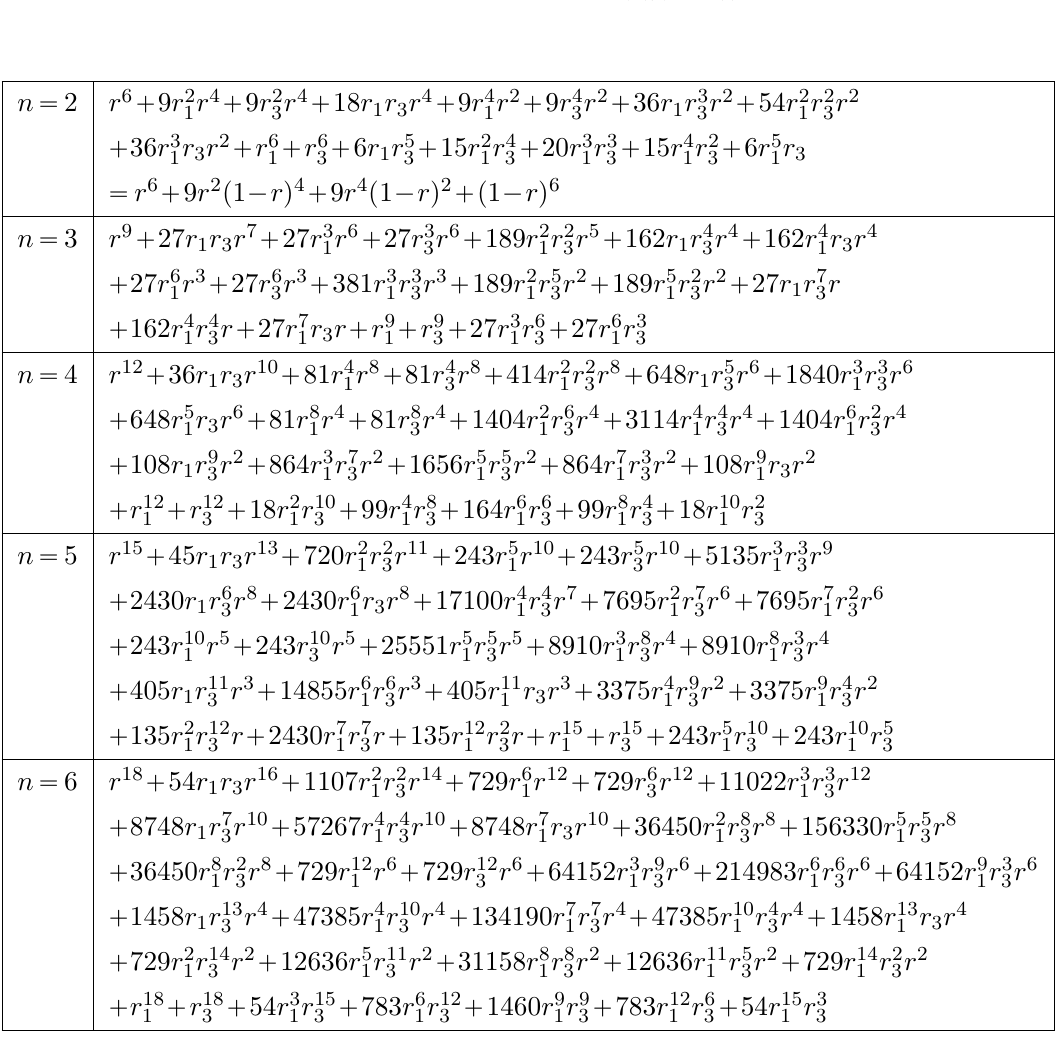
p r 1 ;r 3 qq for k (cid:16) n